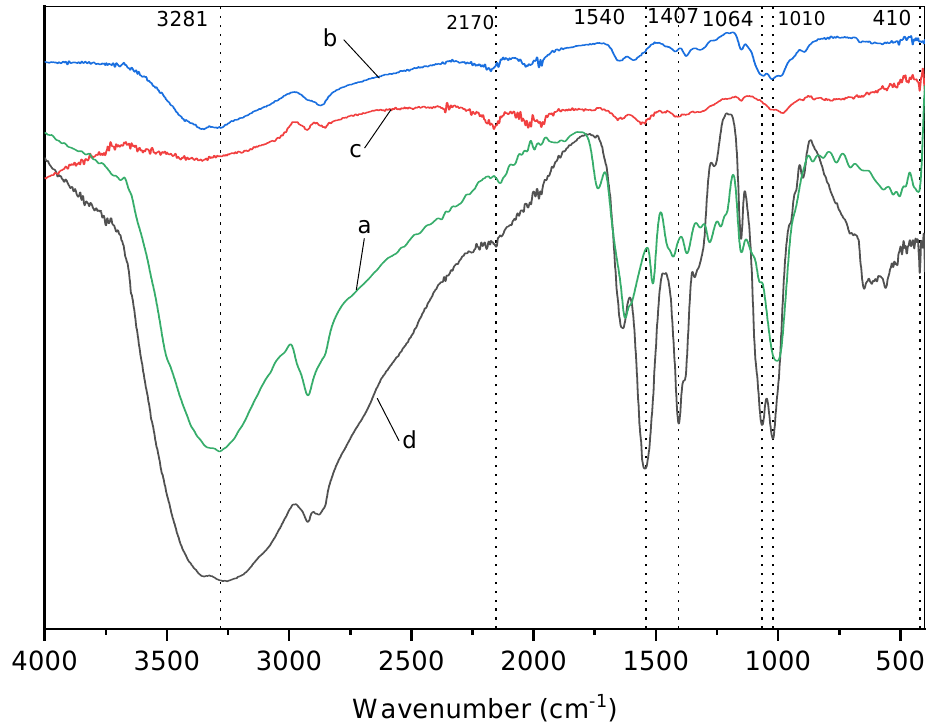
Figure 4. FTIR spectrum of ( a ) curcumin powder, ( b ) pure chitosan, ( c ) chitosan–Ag curcumin hydrogel, ( d ) chitosan hydrogel.